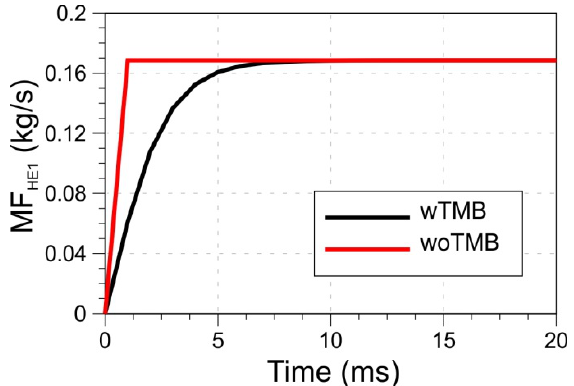
Figure A3. A1-HE1-A2: mass flow traces through the heat exchanger (HE1) calculated: (1) with TMB (wTMB), and (2) without TMB